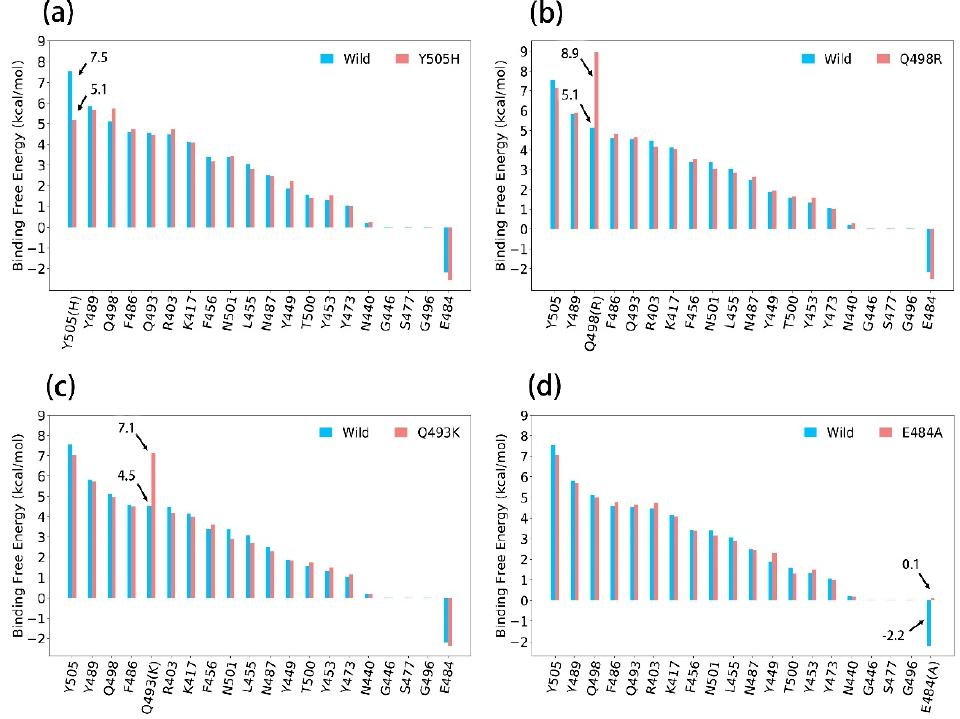
Figure 5. Residue-specific binding free energy data of the S protein between the wild type and the different mutants in binding to ACE2 from the ASGB calculation. (Calculated results were averaged